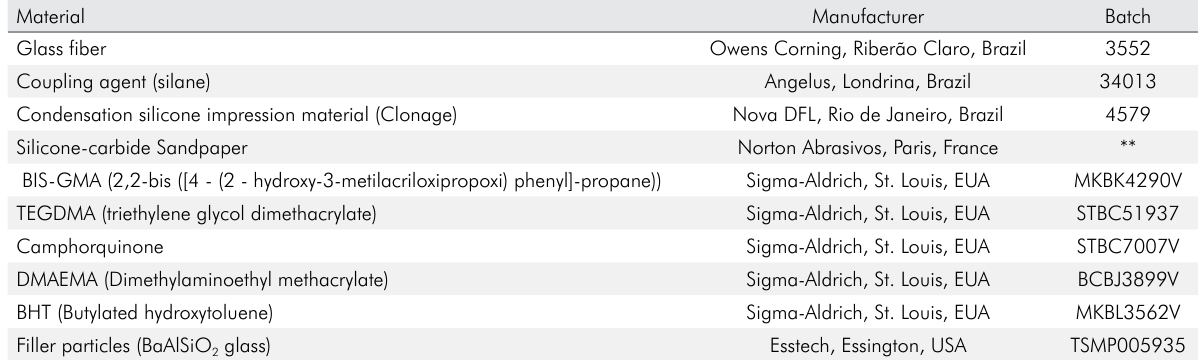
Table 1. Materials used in this study.